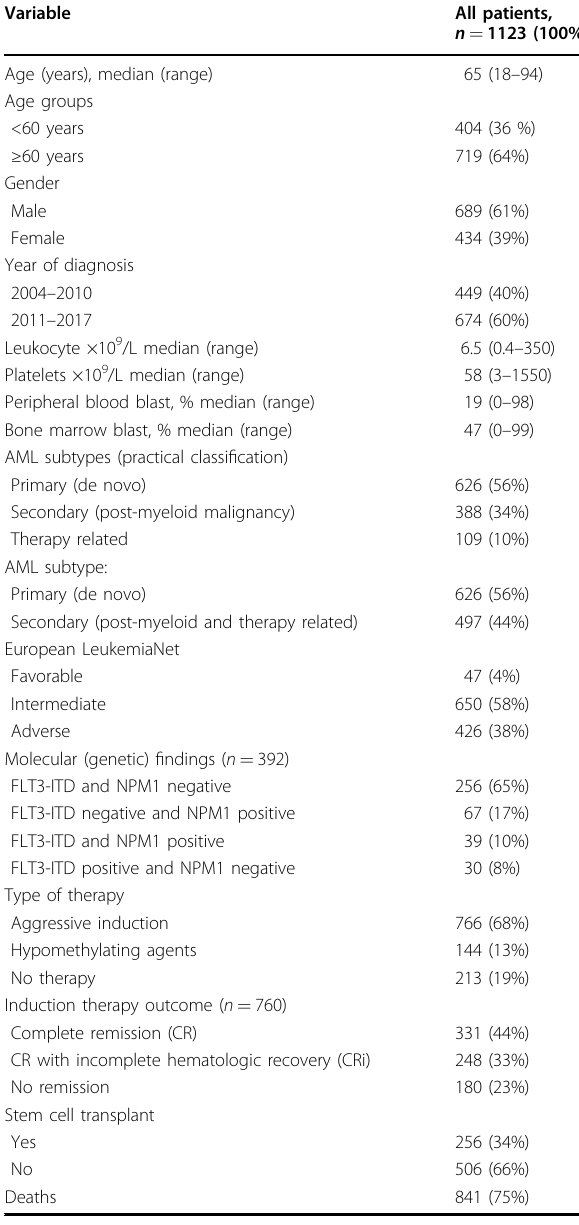
Table 1 Clinical and laboratory characteristics of 1123 acute myeloid leukemia (non-APL)